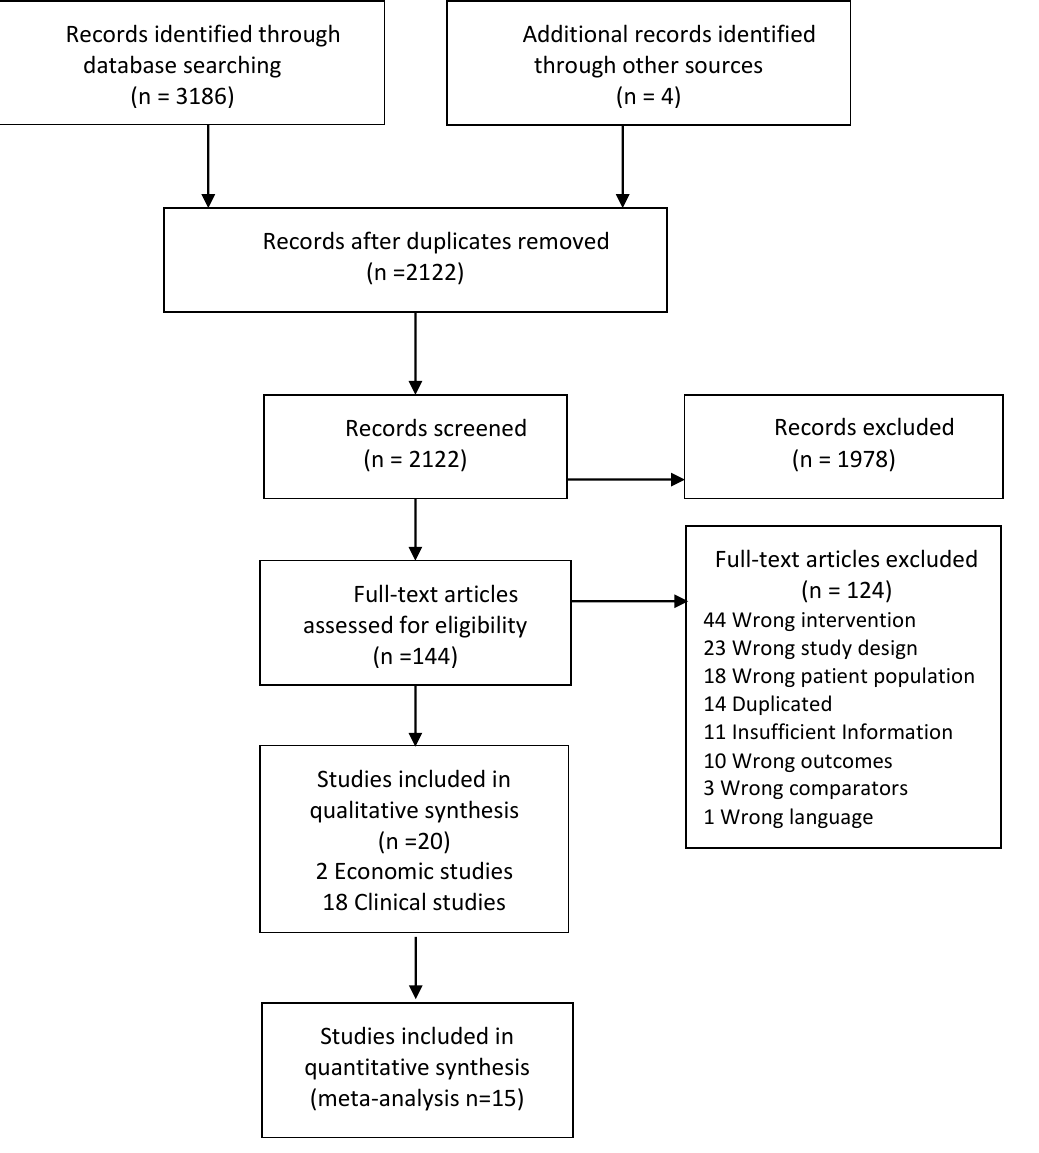
Figure 1. Study flow diagram.